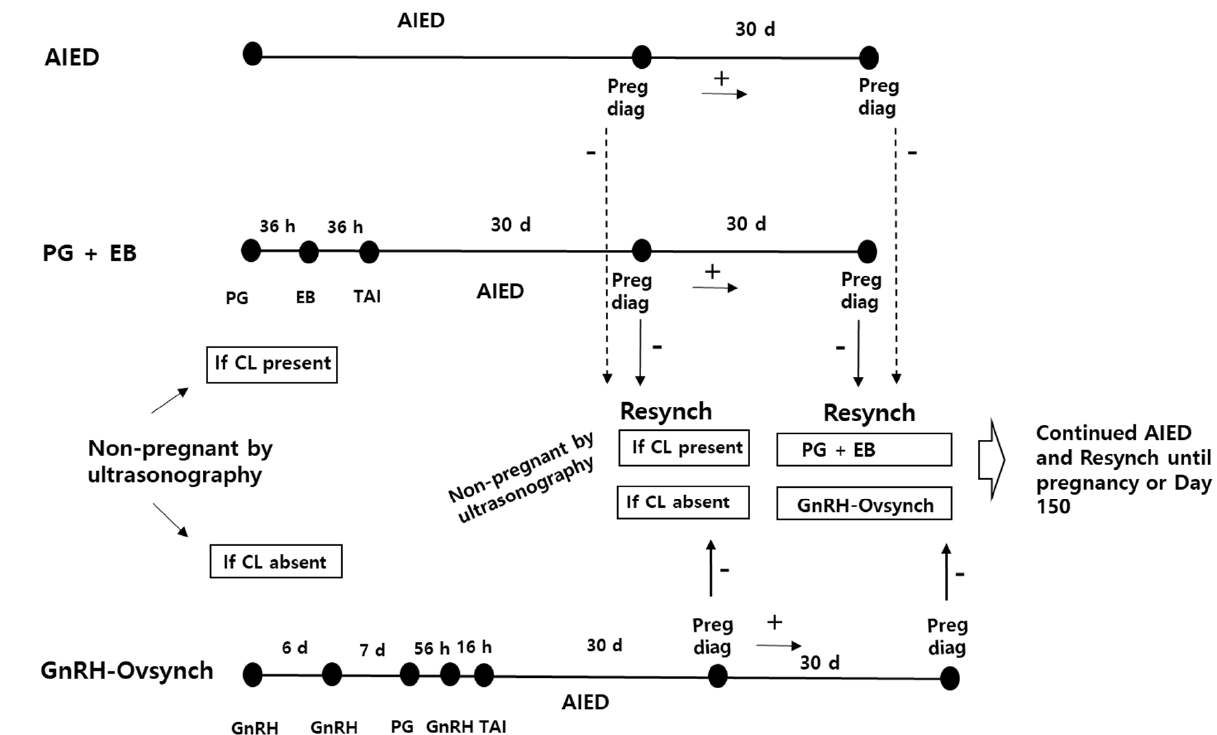
Figure 2. Re-inseminations following AIED or resynchronization programs in cows ultrasonographically confirmed as not being pregnant follow - ing the first or later AI, and pregnancy diagnoses. AIED, cows underwent AI following estrus detection; PG+EB, an injection of EB 36 h later and TAI a further 36 h later; GnRH-Ovsynch, an injection of GnRH, followed by Ovsynch 6 days later. AI, artificial insemination; AIED, artificial insemination following estrus detection; PGF , prostaglandin F ; EB, estradiol benzoate; GnRH, gonadotropin releasing hormone; TAI, timed artificial insemina - 2α 2α tion; d, day; Preg diag, pregnancy diagnosis; Resynch,